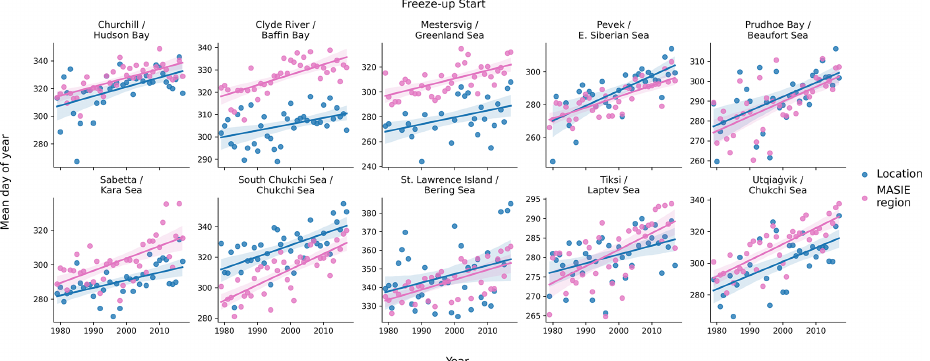
Figure 11. Yearly values (1979–2018) of the freeze-up start dates (shown as day-of-the-year numbers) for the coastal locations (blue) and the corresponding MASIE regions (pink). Date scales on the y axis vary among panels in order to optimize the display of data points. Linear regression lines are shown with the same color coding. In each panel, the upper line of header identifies the coastal location and the lower line lists the MASIE region. All values are based on the modified J&E algorithms. See Tables S2 and S3 for slopes and significance